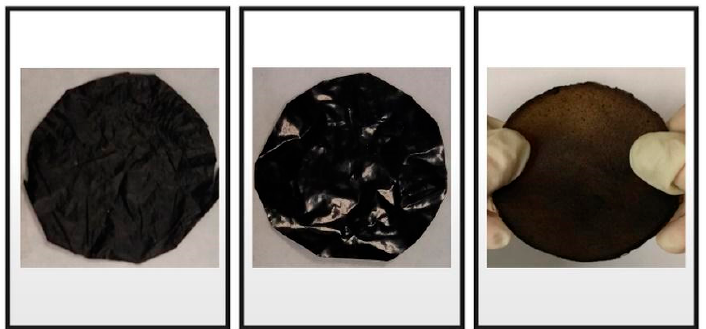
Figure 1. Representative films used in the experiment (left to right): Mater-Bi, polyethylene, the innovative protein-based film.